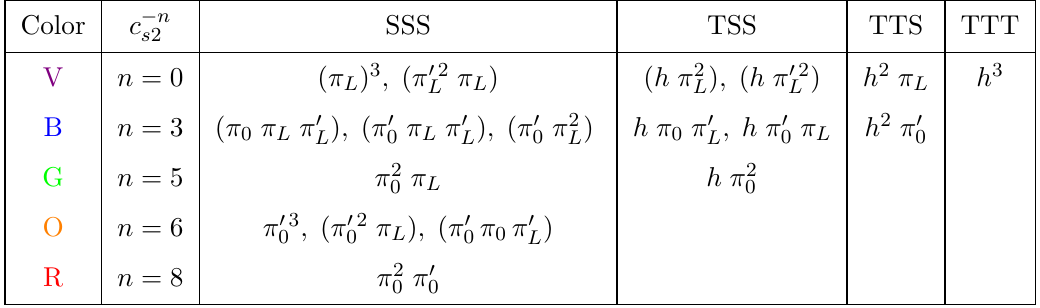
, n = 0 , . . . , 8 s 2 (cid:11) , in the limit = − 1 . When c 2 = 0 the c c s 2 (cid:28) 1 and c 2 s 2 n b b = − 1 b